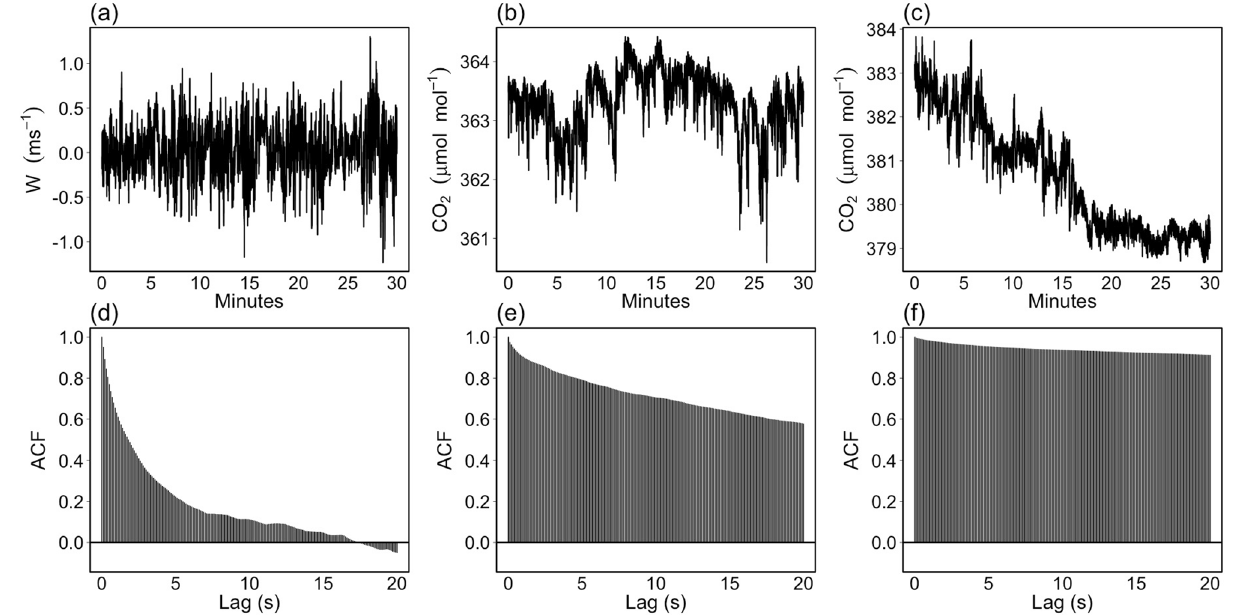
1 Figure 2. Raw, high-frequency vertical wind speed ( w , m s − , a ) and two time series of carbon dioxide 1 concentrations (CO 2 , µ mol mol − , b, c ) from FI-Sii site. Their corresponding autocorrelation functions (ACF) are depicted in ( d – f